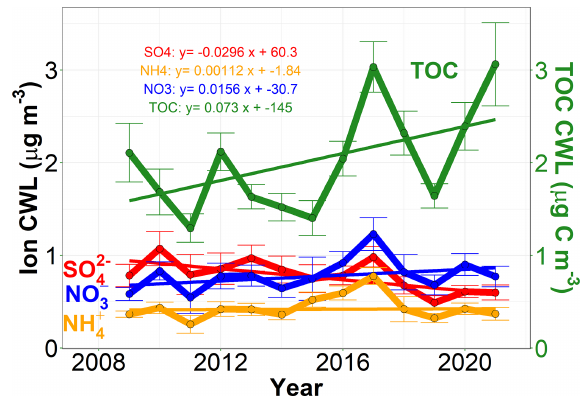
Figure 6. Linear trends in annual median cloud water loadings (CWLs) for the major inorganic ions and TOC between 2009–2021 for the complete dataset, using the meteorology criteria outlined in the Supplement, Sect. S5 to calculate average in-cloud LWC values associated with each